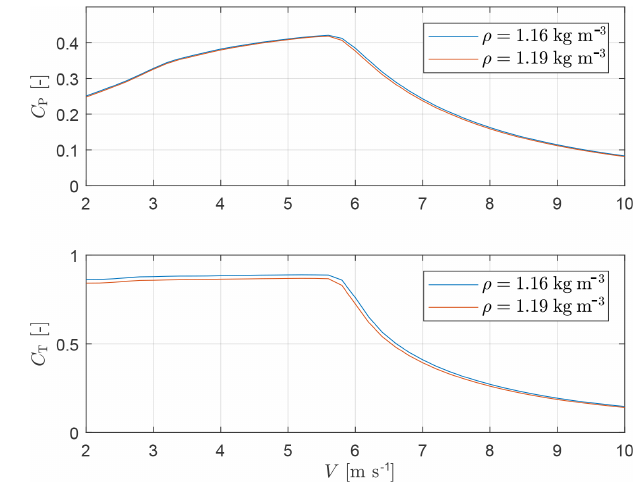
Figure 4. Power and thrust coefficients vs. wind speed for the G1